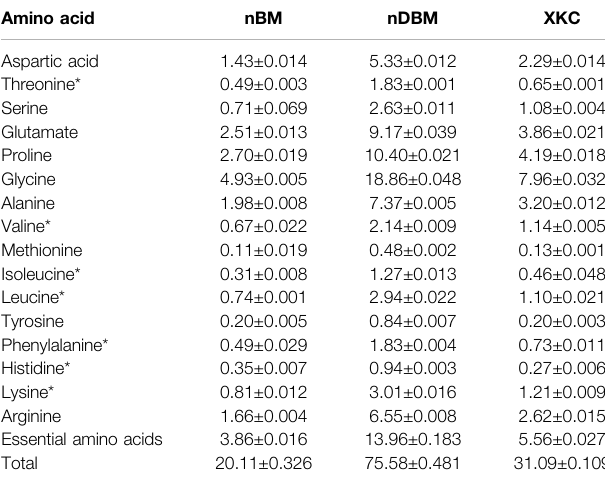
TABLE 2 | Amino acid composition and content of different bone powders